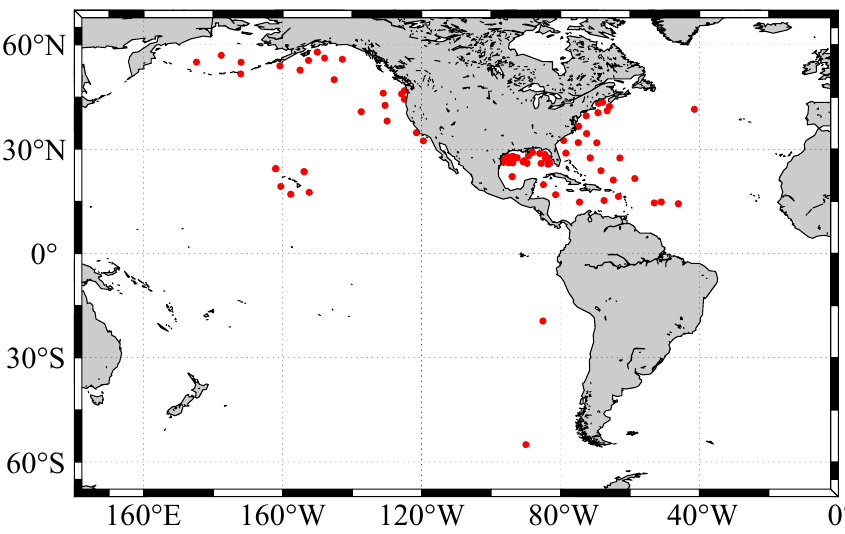
Figure 1. Locations of the NDBC buoys used in this study.